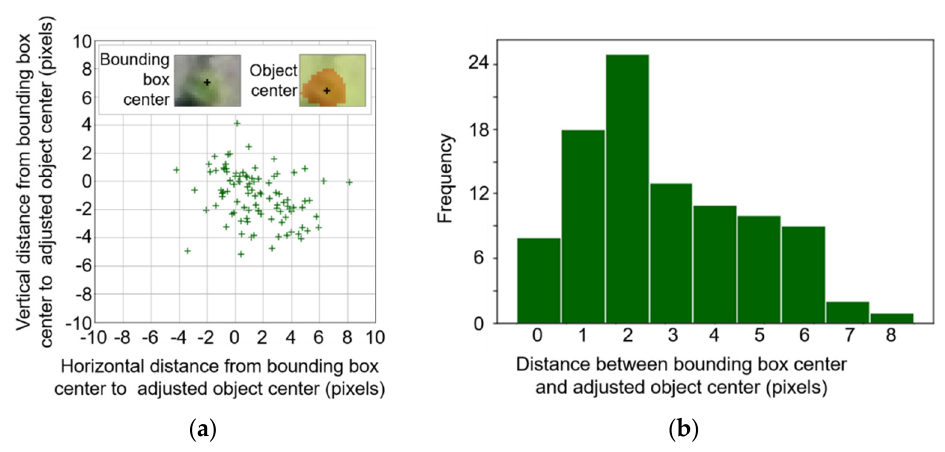
Figure 6. Displacement between bounding box center and object center in a ( a ) horizontal and vertical direction, with ( b ) the histogram of the distance. The adjusted object center location was calculated as the geometric center of canopy pixels derived by a Canopeo-based algorithm [43].